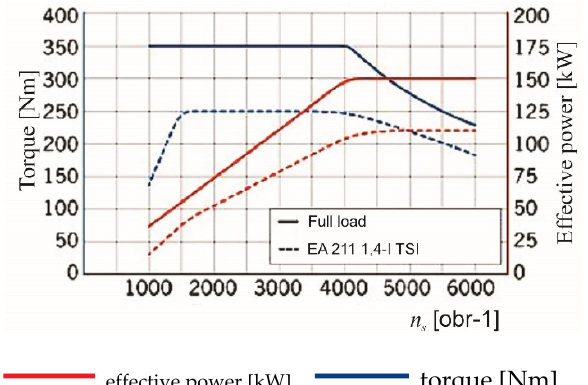
Figure 4. Characteristics of the hybrid drive system (PHEV) of the VW–Audi group for the MQB construction platform [8]: max. power of the combustion ICE/electric engine—110 kW/80 kW, max. torque of the combustion/electric engine—250 Nm/330 Nm, max. system torque—350 Nm, max effective system power—150 kW.